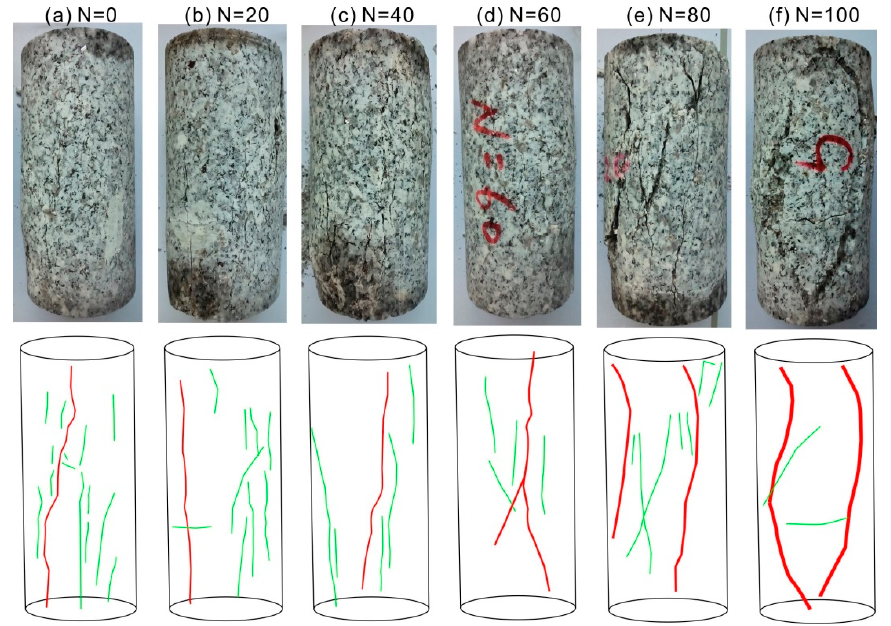
Figure 20. Comparison of the macroscopic failure morphology of the freeze–thawed granite samples after UCS test.